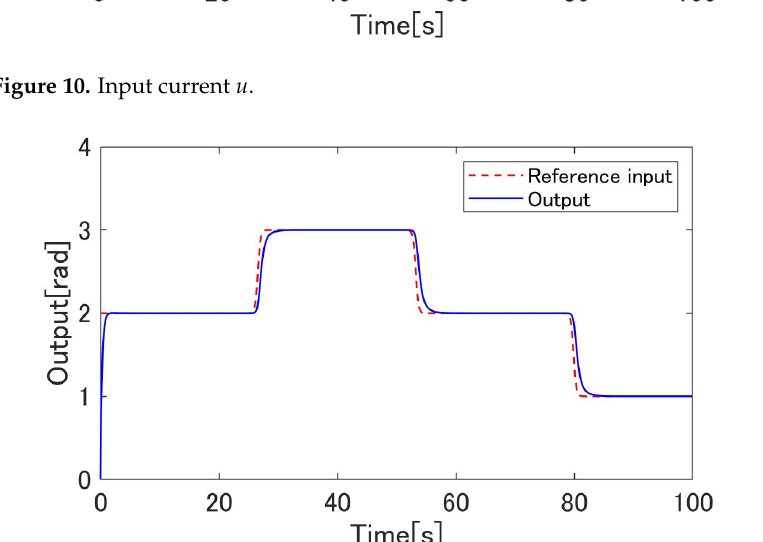
Figure 11. The output angle θ of the proposed method.